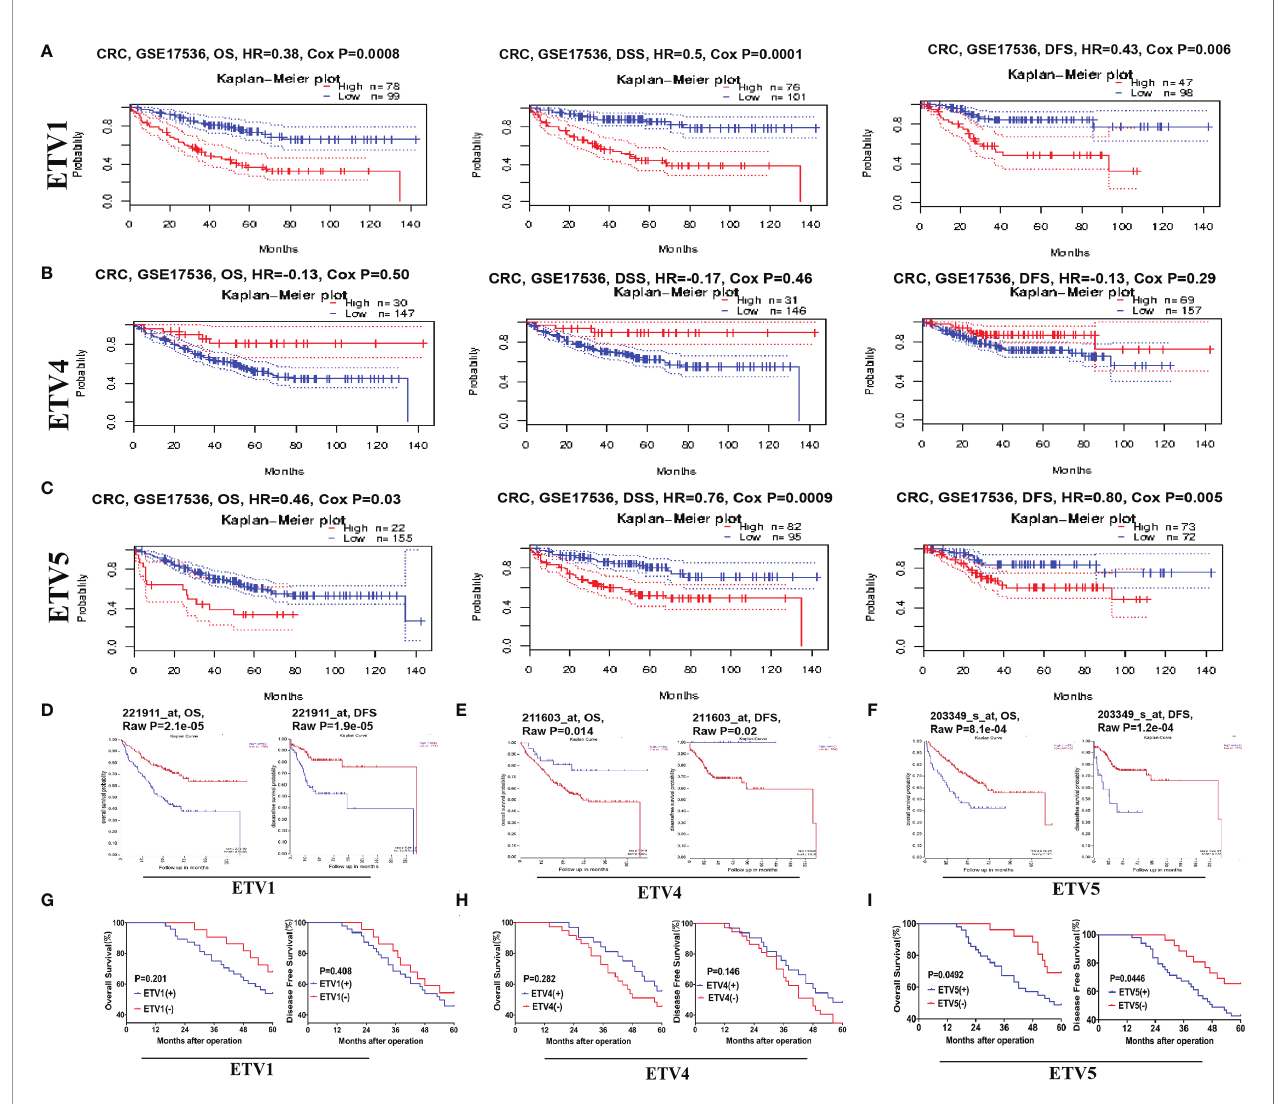
FIGURE 2 | Kaplan – Meier survival analysis of CRC based on the different expression levels of ETV1, ETV4, and ETV5. (A – C) Survival curves of overall survival (OS), disease-speci fi c survival (DSS), and disease-free survival (DFS) in CRC cohorts via ProgonoScan (GSE:17536, n = 177) based on ETV1, ETV4, and ETV5 expression level. (D – F) Survival curves of OS and DFS in CRC cohorts via R2 platform based on ETV1, ETV4, and ETV5 expression level. (G – I) DFS and OS curves of the 75- patient cohort, with patients strati fi ed based on the expression levels of ETV1, ETV4, and